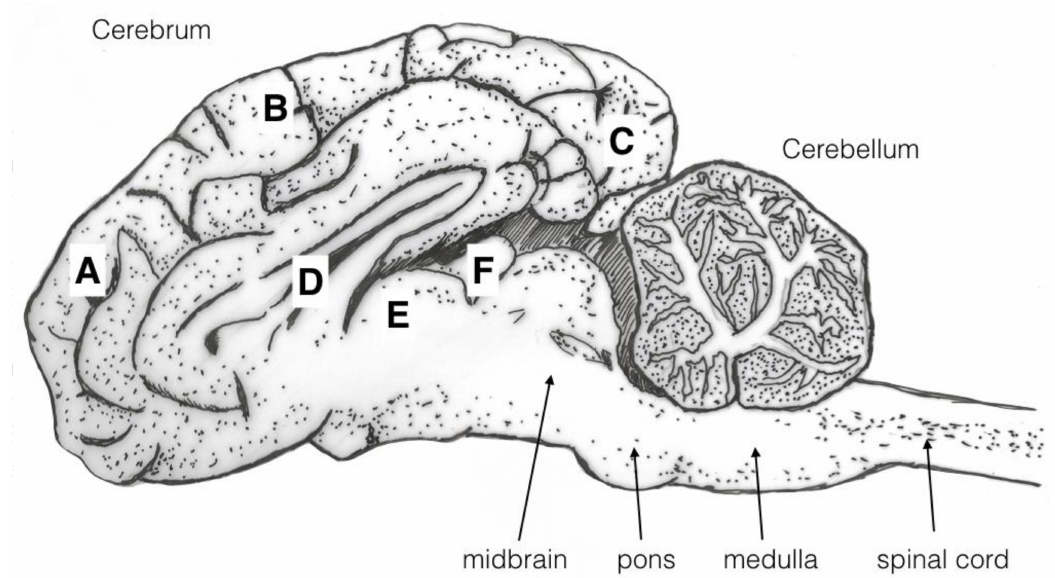
Figure 4. Diagram of a sagittal section of a brain illustrating the areas examined for macroscopic damage. Areas are labelled as frontal cerebrum (A), parietal cerebrum (B), occipital cerebrum (C) and lateral ventricle (D). These were scored on the basis of 0 = no damage, 1 = slight deformation, 2 = moderate deformation and 3 = severe deformation of the area. The frontal (A), parietal, and (B) occipital cerebrums (C), lateral ventricle (D), thalamus (E), pineal gland (F), midbrain, pons, medulla and cerebellum were assessed for the presence or absence of